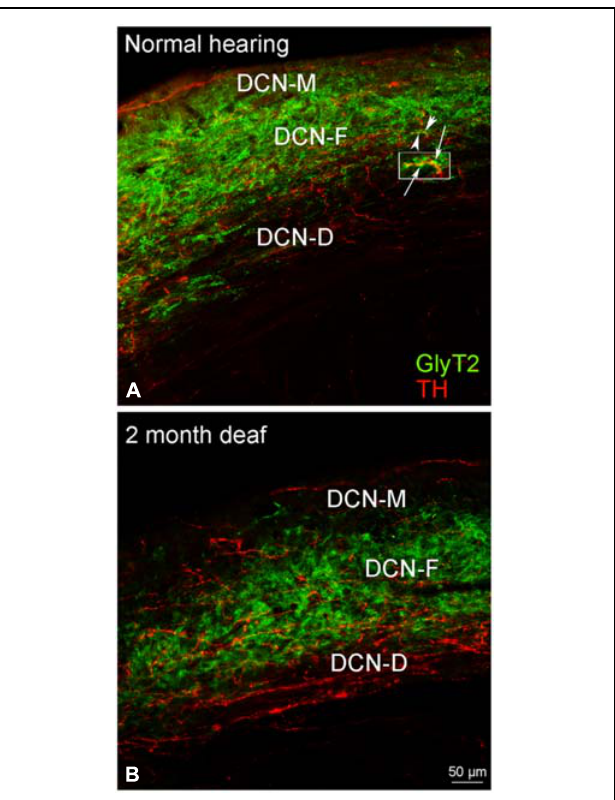
FIGURE 8 | In the DCN, GLYT2 labeling is robust throughoutmost of the DCN. While both GLYT2 (green) and TH (red) labeling is localized to dendrites and terminals (A,B) , the labeling is primarily complimentary. Following deafness GLYT2 labeling is dramatically decreased in each layer of the DCN, especially in DCN-M and DCN-D. Arrowheads indicate regions of TH and GLYT2 interaction enlarged at arrows. Scale bar: 50 μ